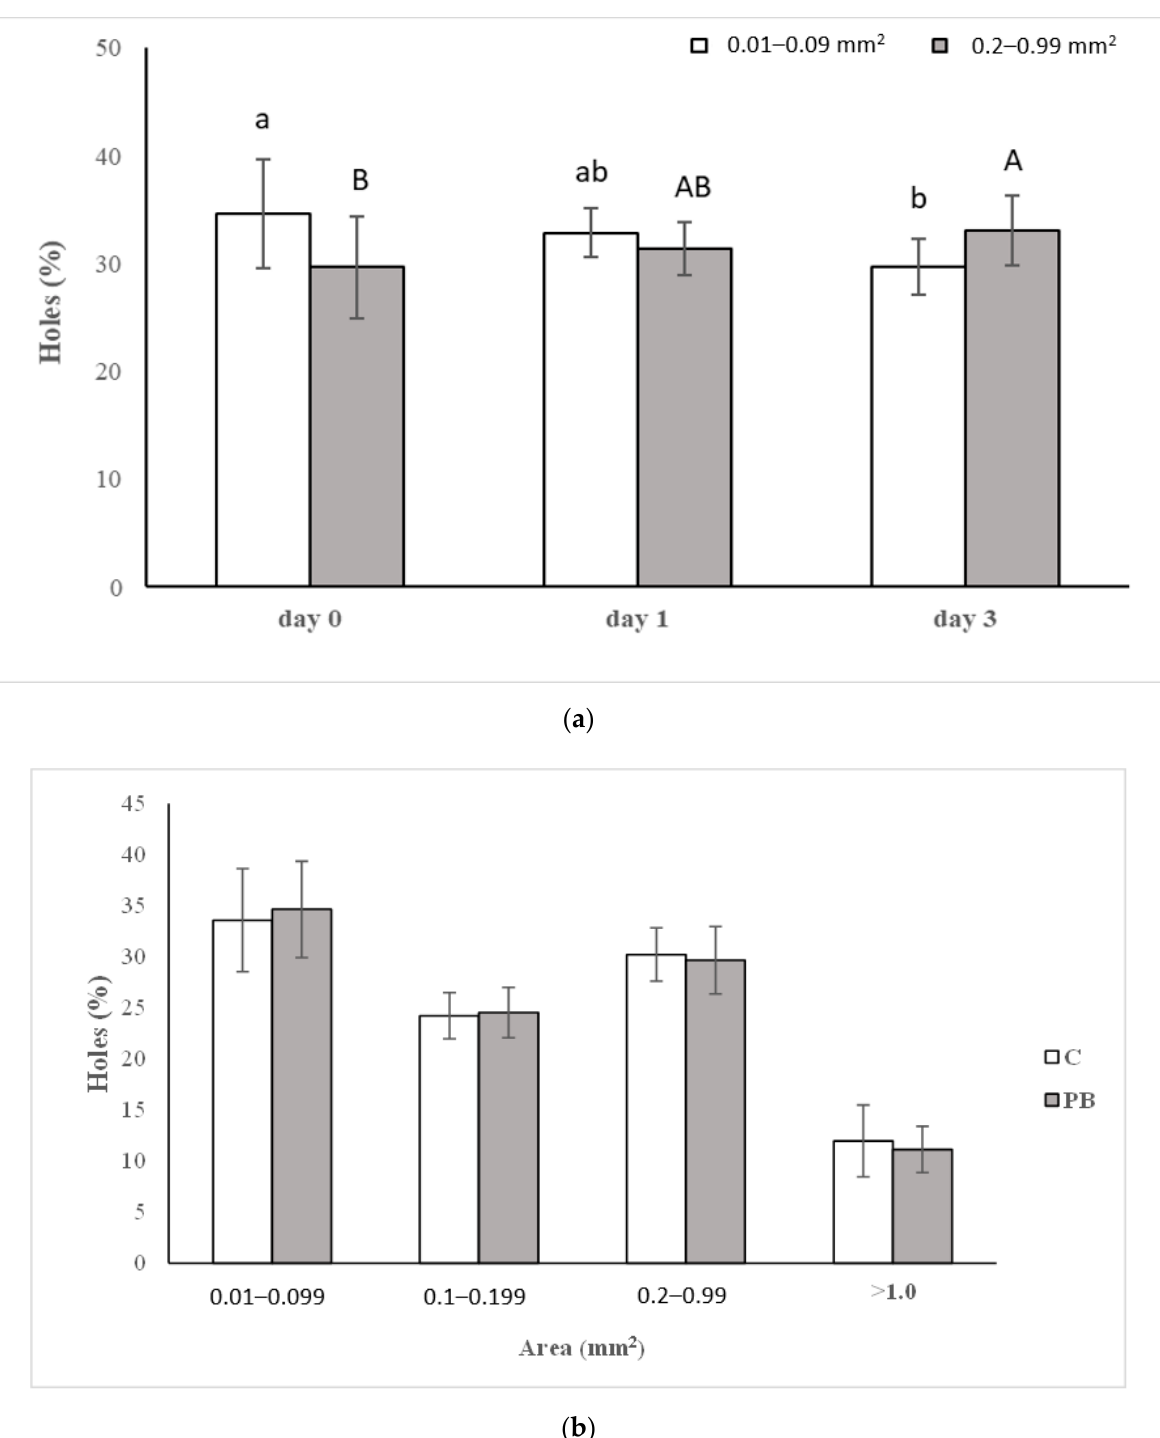
Figure 3. Appearance of control and parchment enriched breads.